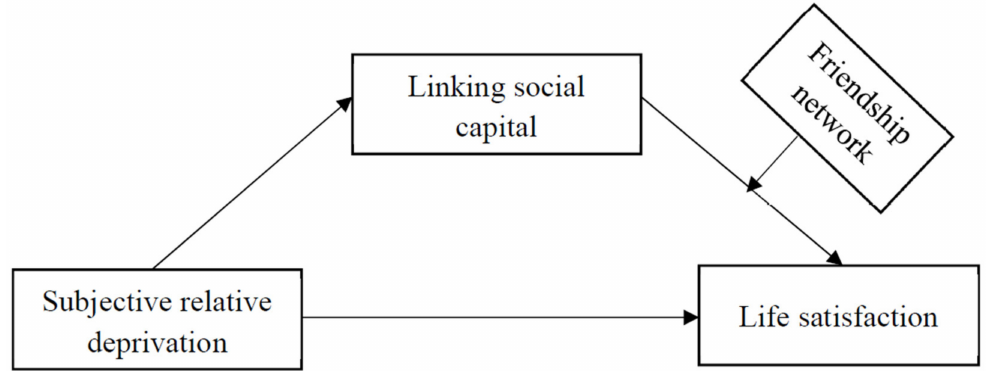
Figure 1. The conceptual model including subjective relative deprivation, linking social capital, life satisfaction and friendship